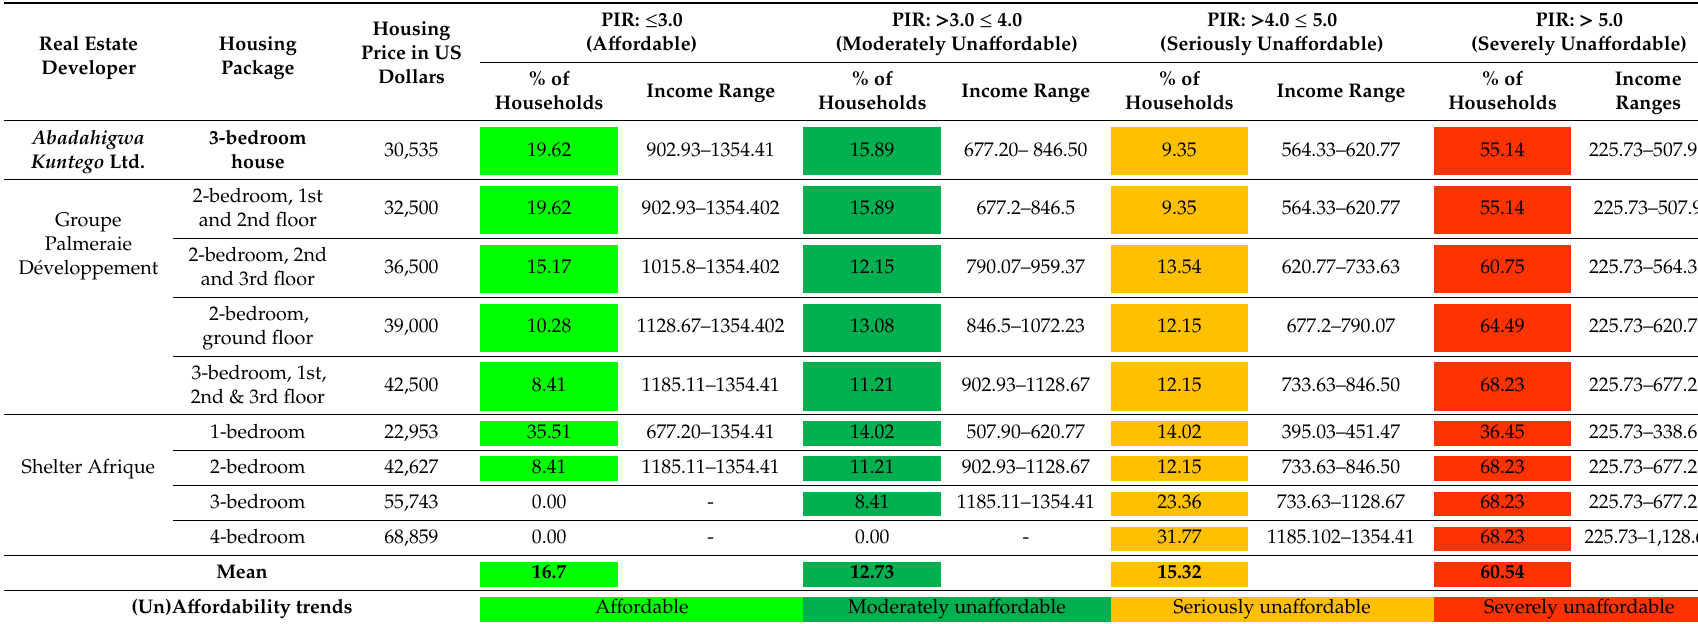
Table 4. Trends in housing a ff ordability based on the housing-price-to-income ratio. Data source: field survey (July to September 2018 and January to March 2019) and review of housing price lists held by real estate